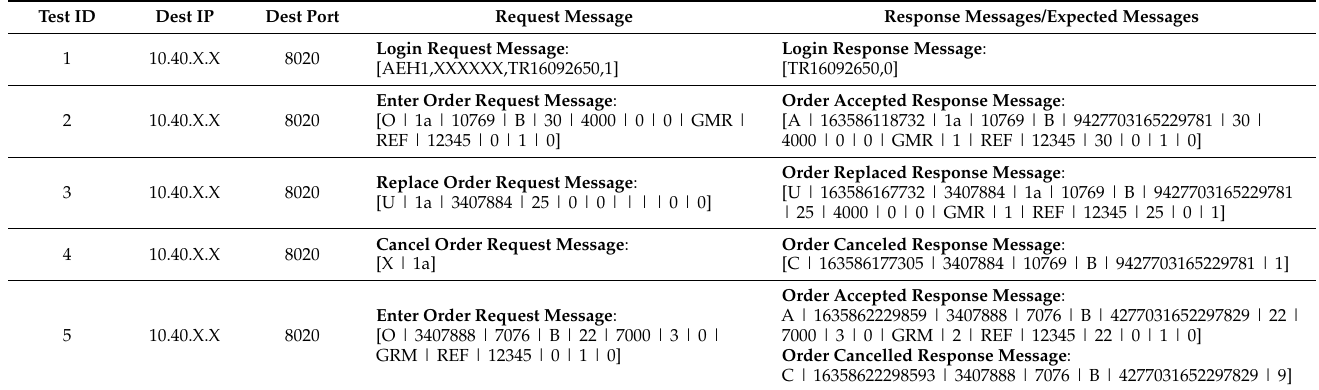
Table 5. Selected OUCH-API test cases extracted from